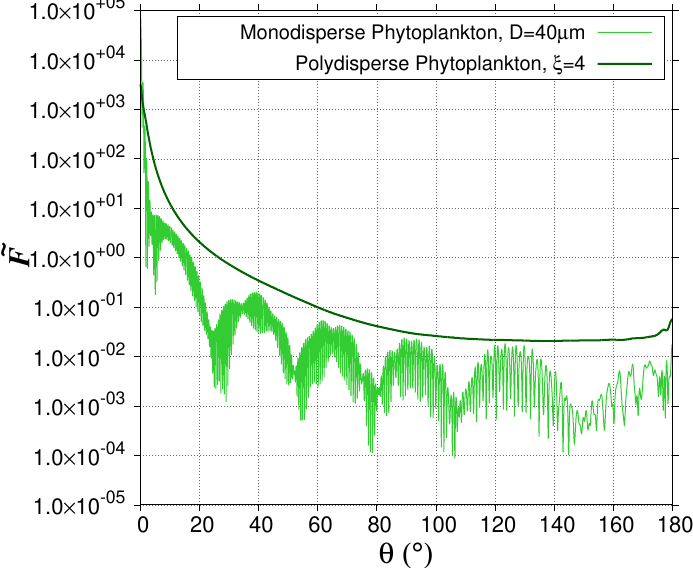
Figure 3. Interference and resonance features observed for the scattering phase function of monodisperse particles (light green). The major low-frequency maxima and minima are called the “interference structure”. The high-frequency ripples are resonance features. The interference and resonance feature are washed out for a polydisperse assemblage of particles (dark green). Using the DS1 data set, the impact of the angular integration on the backscattering ratio (cid:102) b θ a examined as a function of the hyperbolic slope ξ for different values of the real refractive index and two values of total angular steps (i.e., N θ = 750 and 3600) (Figure 4). The impact of the integration is noticeable only for ξ values lower than about 3 and relatively high n r values. When the number of angular steps increases, the curves become flatter at low ξ values. Differences in the curve shape are reduced if we increase the angular step. For ∆ θ = 0.24 o (N θ = 750), the present results of the Lorentz-Mie calculations (solid lines in Figure 4) perfectly match those previously obtained by Twardowski et al. [5] (not shown). However, in this case (N θ = 750), the numerical integration is not accurate enough as the integration of Equation (1) gives values between 1.999 ( ξ = 4.9) and 1.04 ( ξ = 2.5). In the following, ∆ θ is set to 0.05 o (N θ = 3600) and Figure 4 (dashed lines) will be the reference figure for homogeneous